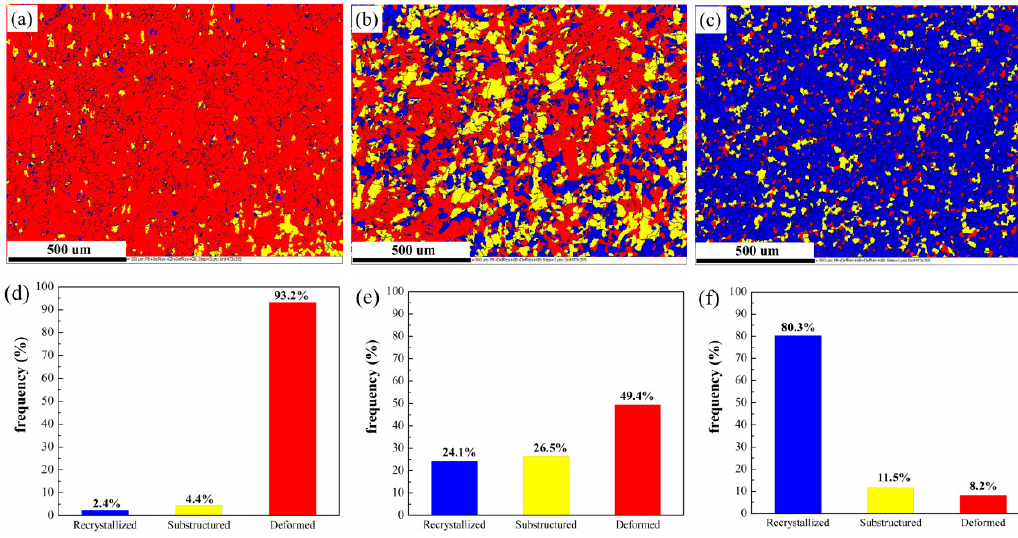
Figure 7. Dynamic recrystallization distribution maps ( a – c ) and statistics maps ( d – f ) of the deformed specimen at various true strains: ( a , d ) ε = 0.105; ( b , e ) ε = 0.223; ( c , f ) ε = 0.916.